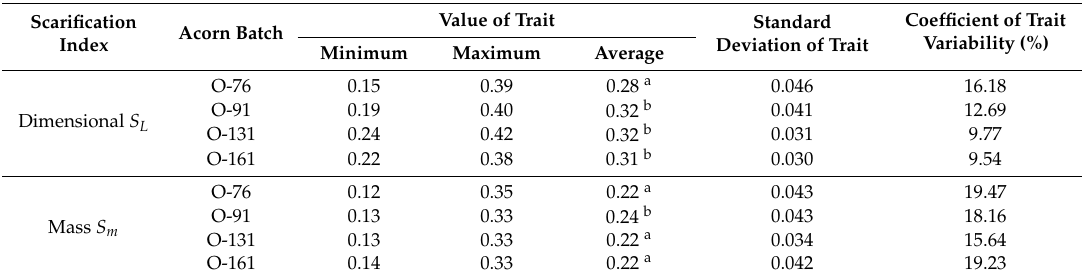
Table 2. Statistical distribution and significant differences in the scarification index of acorns from four batches.